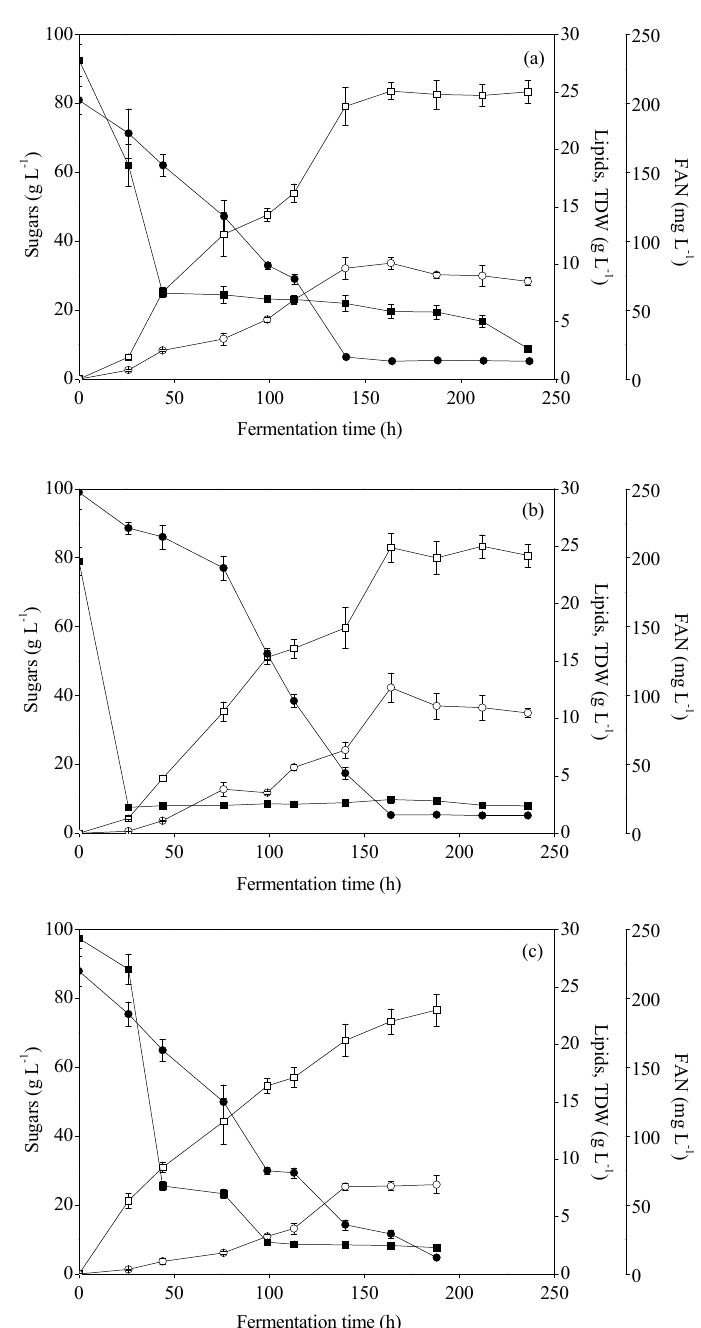
Figure 1. Concentration of sugars ( (cid:8) ), free amino nitrogen (FAN) ( (cid:4) ) and production of total dry weight (TDW) ( (cid:3) ) and microbial lipids ( ), during shake flask cultures of R. toruloides on ( a ) mixed food for infant (MFI) hydrolysates, ( b ) mixed confectionery waste streams (MCWS) hydrolysates, and ( c ) mixed waste streams (MWS) hydrolysates.